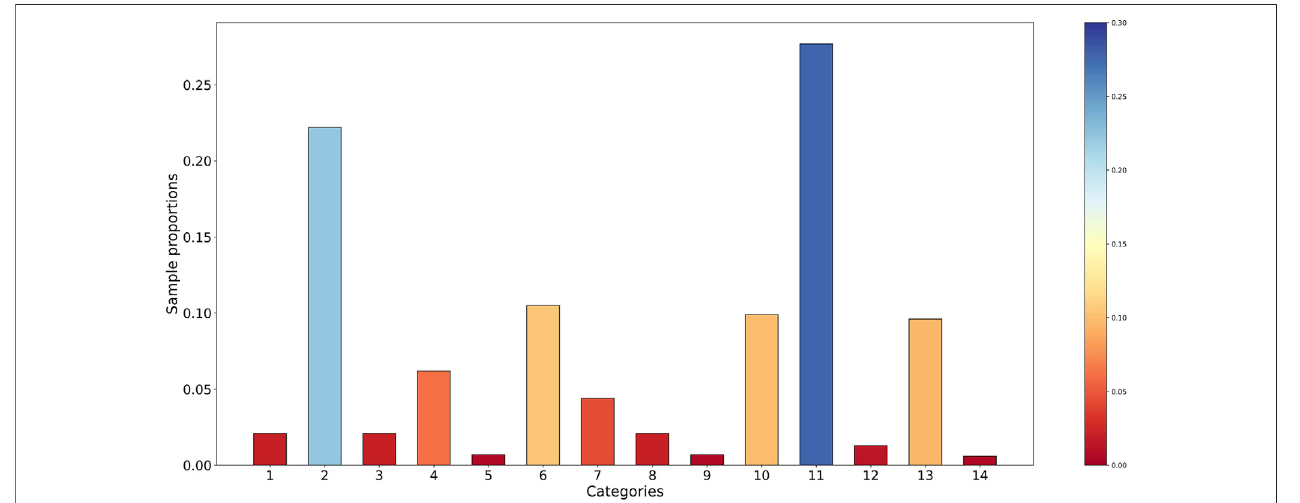
FIGURE 4 | The sample proportion of the benchmark